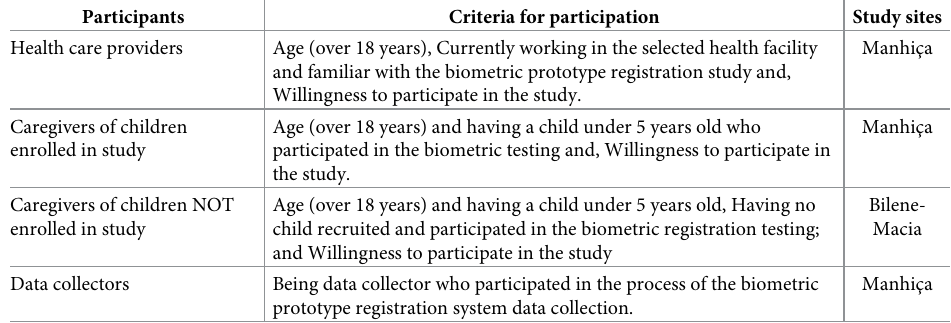
Table 2. Inclusion criteria for the study